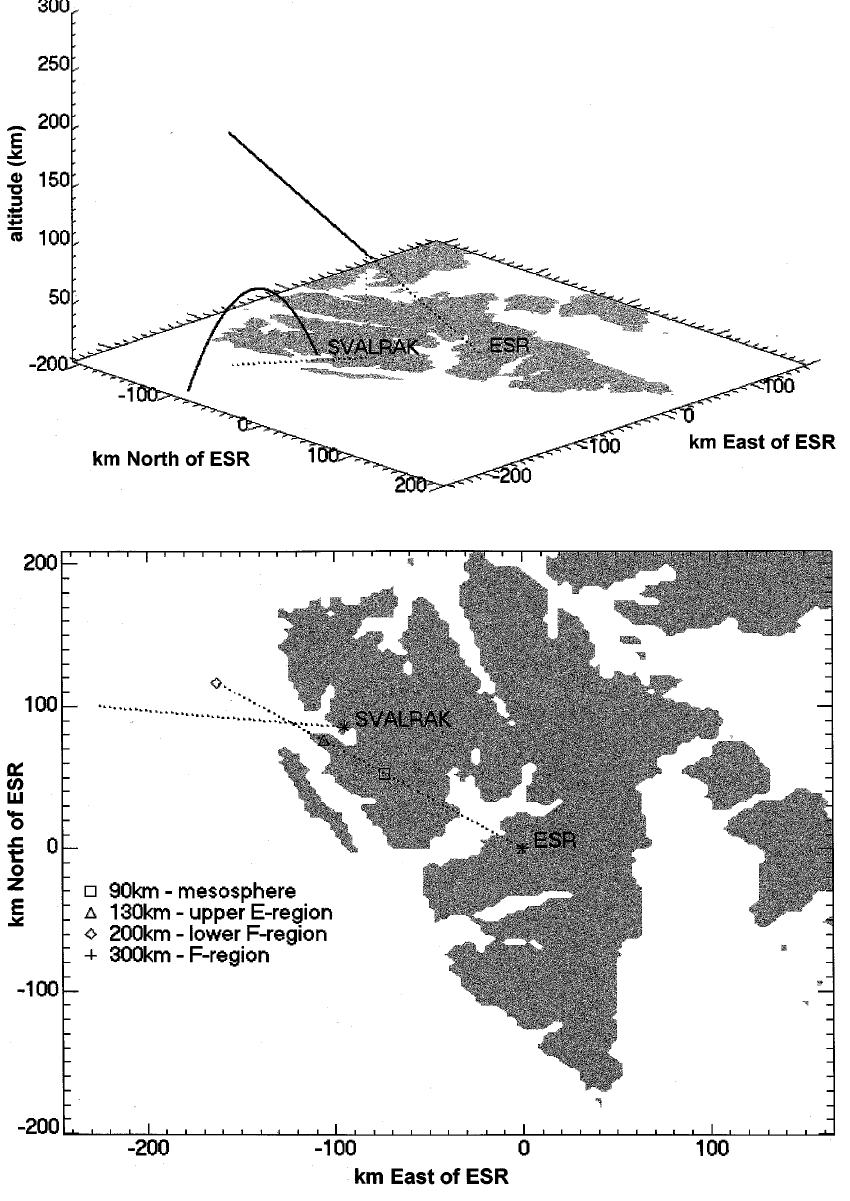
Fig. 2. Two-dimensional representation of the measurement geometry. This is essen- tially a plan view of the previous figure, but indicates intersections of the ESR beam with selected altitudes. The apogee of ISBJØRN I was 70 km and is this repre- sented by the mid-point of the line extending west